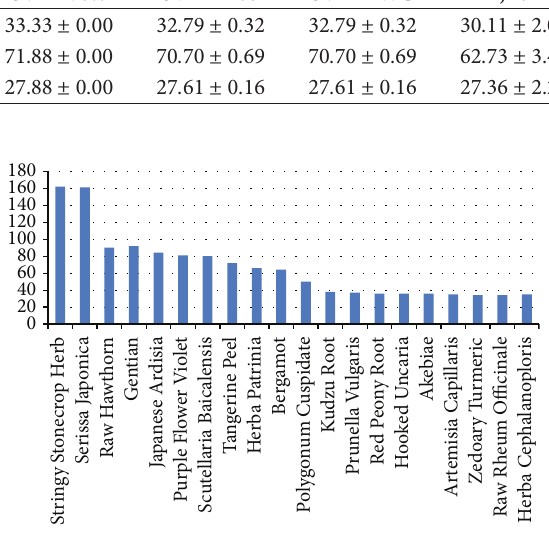
Figure 9: The first 20 most frequently used herbs and their normalized frequency except 8 herbs in basic core formula. Table 5: The most frequent 𝑛 -itemsets and their